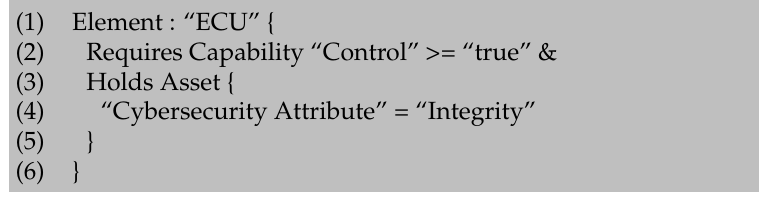
Figure A6. Anti-Pattern for Rule